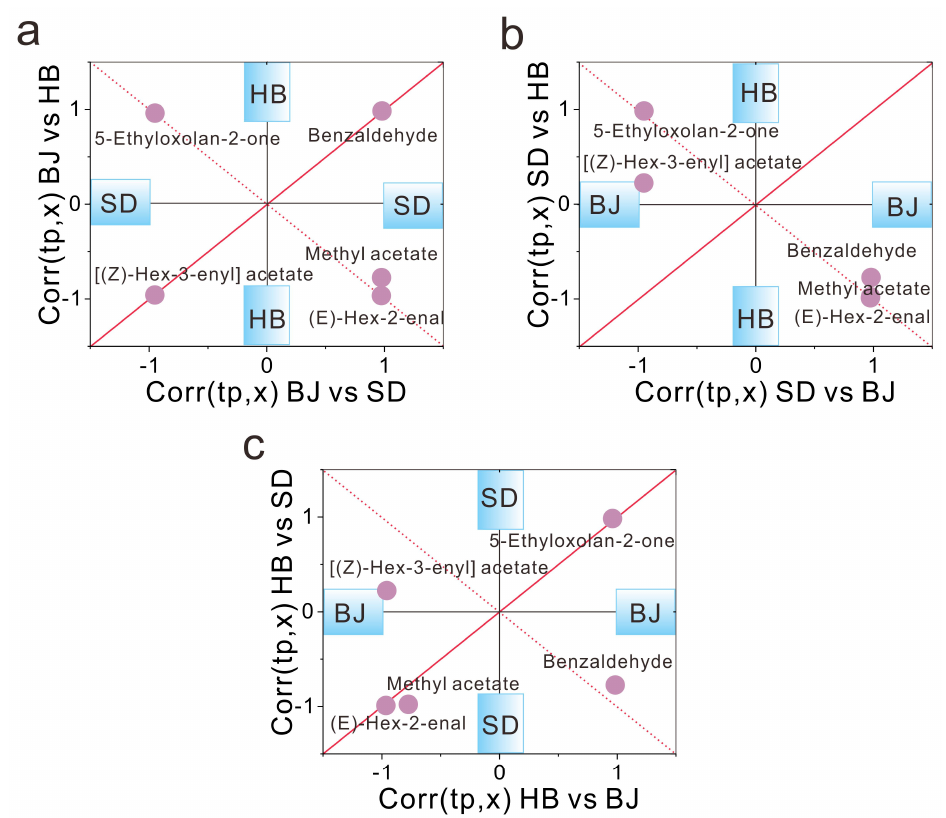
Figure 3. The SUS-plots among BJ, HB, and SD. ( a ) BJ vs. SD and BJ vs. HB; ( b ) SD vs. BJ and SD vs. HB; ( c ) HB vs. BJ and HB vs. SD. The aroma compounds close to the diagonal line are equally affected in both lines and considered as common potential biomarkers; the aroma compounds close to the x axis are specific for cultivation in x axis and close to y axis are specific for cultivation in y axis.